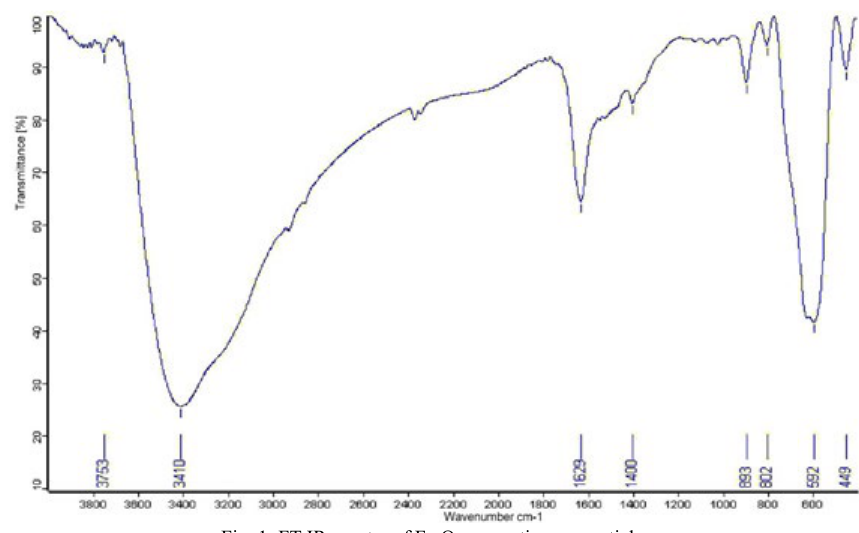
Fig. 1: FT-IR spectra of Fe Figure 1: FT-IR spectra of Fe 3 O 4 magnetic nanoparticles